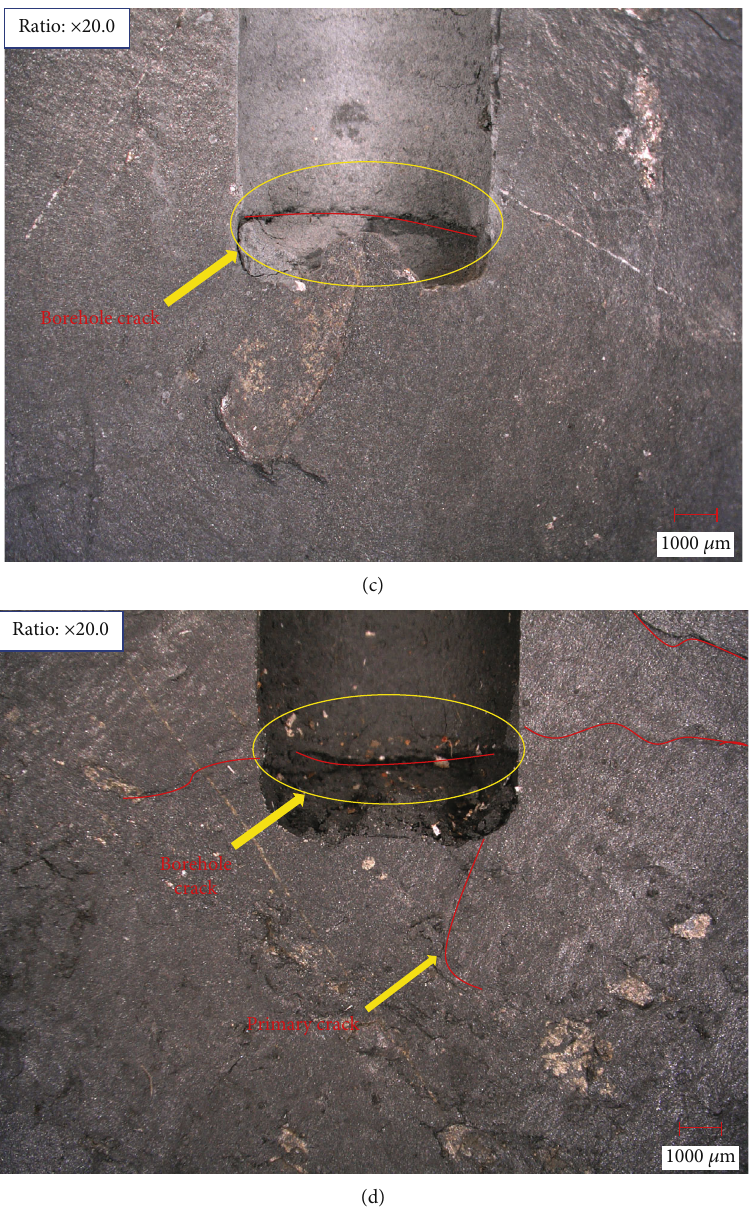
Figure 12: The crack propagation around the borehole: (a) dry and parallel bedding shales; (b) saturated and parallel bedding shales; (c) dry and vertical bedding shales; (d) saturated and vertical bedding